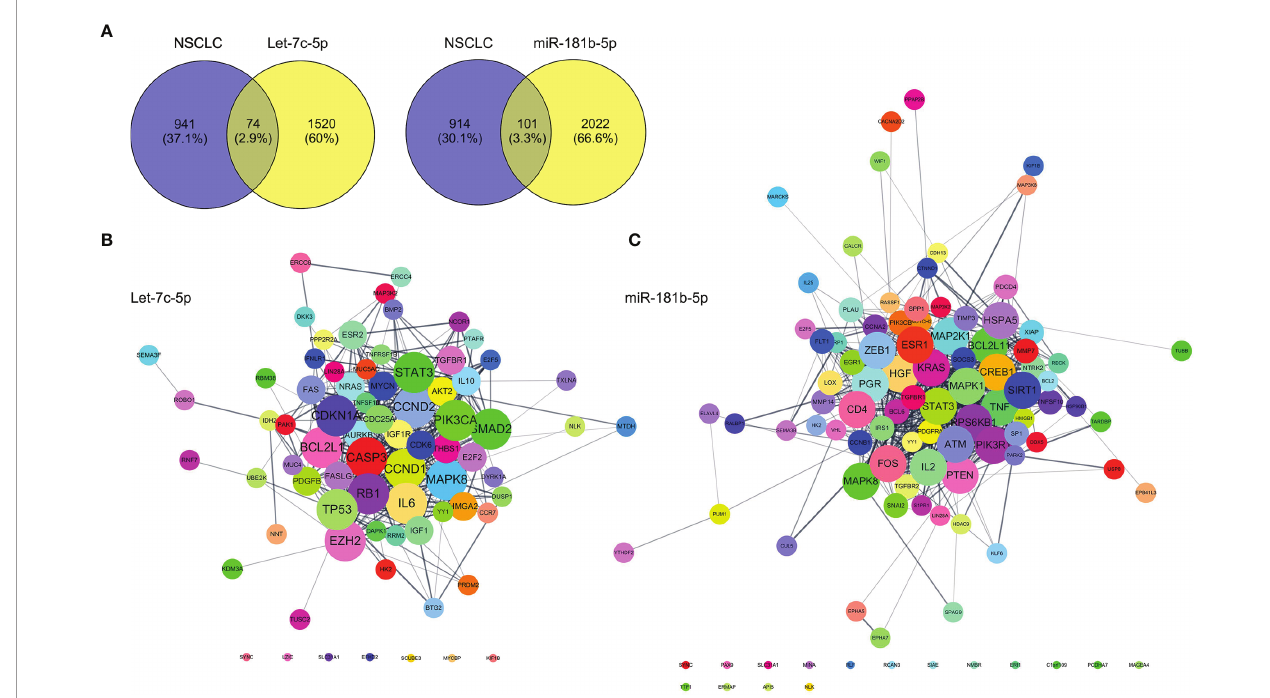
FIGURE 7 | Prediction of let-7c-5p and miR-181b-5p target gene. (A) The common targets of retrieval NSCLC relative targets compared with the predicted miRNA targets of let-7c-5p and miR-181b-5p, respectively. The PPI network with the common targets of (B) let-7c-5p and (C) miR-181b-5p with